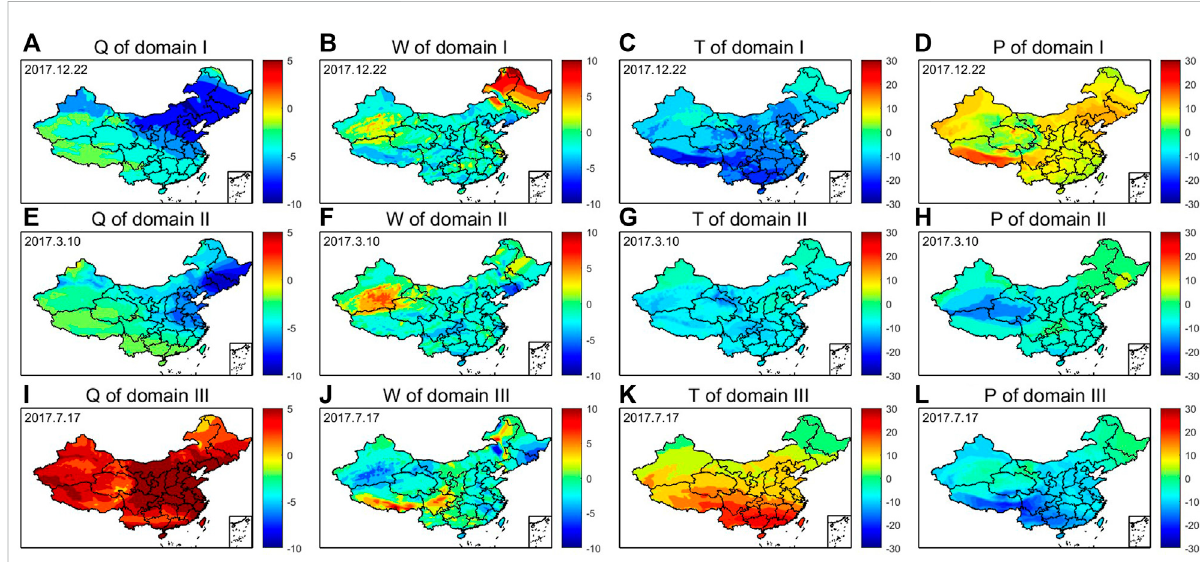
FIGURE 4 TypicalweatherconditionsforthreedomainsofPM 2.5 -AODrelationships.Theanomalous (A,E,I) speci fi chumidity(gkg − 1 ) (B,F,J) windspeed(m